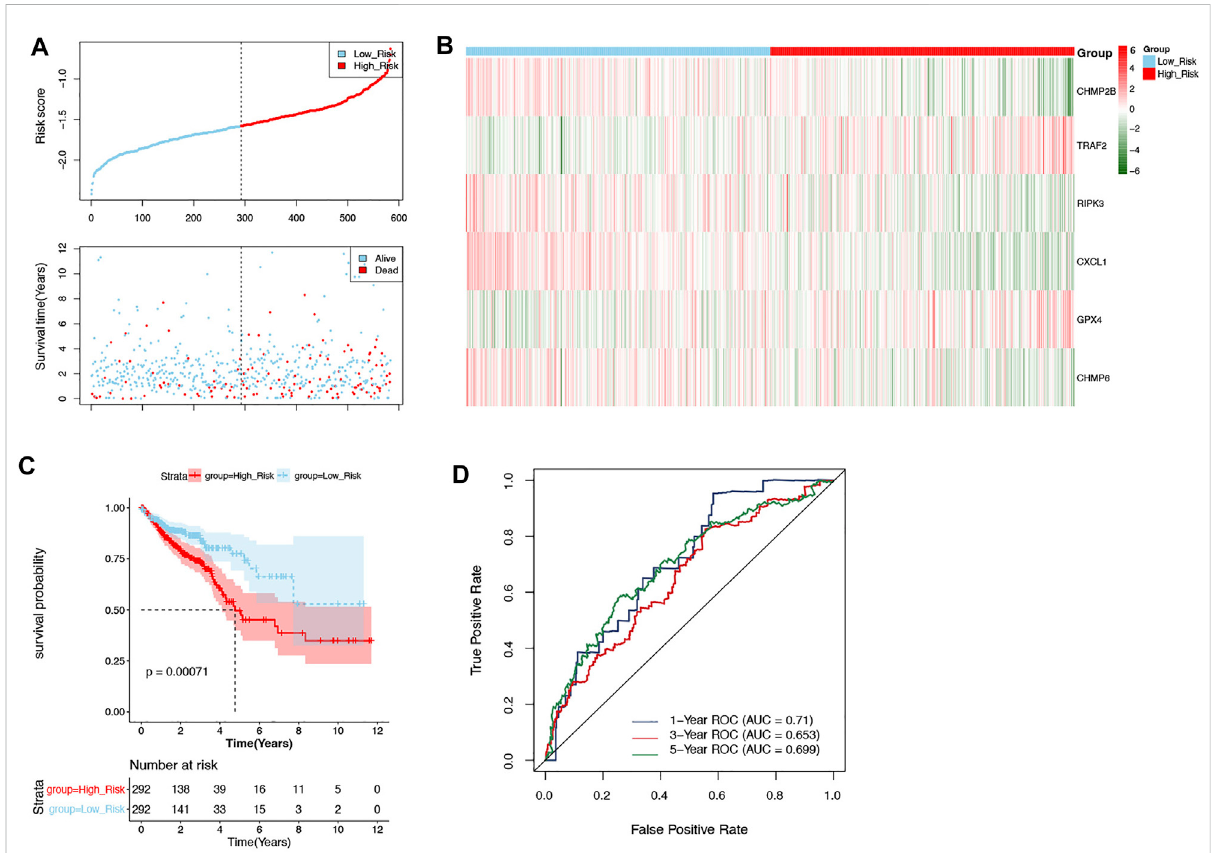
FIGURE 3 Evaluationoftheprognosticsignatureinthetrainingset. (A) Thepatientsinthetrainingsetwerecategorizedintohigh-riskandlow-riskgroups. (B) The expression of 6 DENRGs in high-risk and low-risk groups. (C) The Kaplan – Meier curve of high-risk and low-risk groups. (D) The ROC curve was used to assess the accuracy of the prognostic